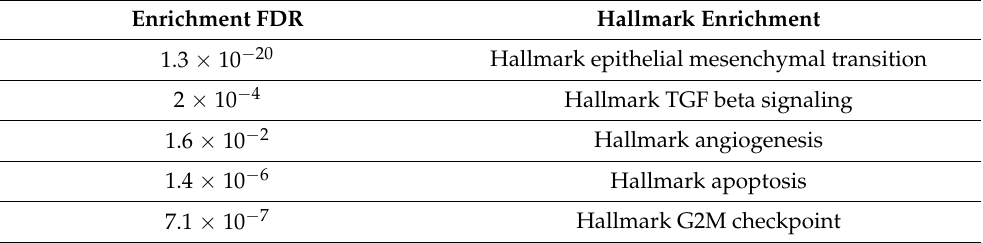
Table 4. The top pathways for strong A 2A R expression obtained by Hallmark enrichment in CGGA